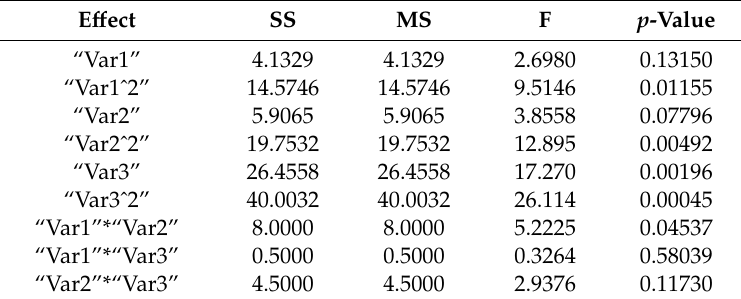
Table 5. Estimated regression results of di ff erent variables.